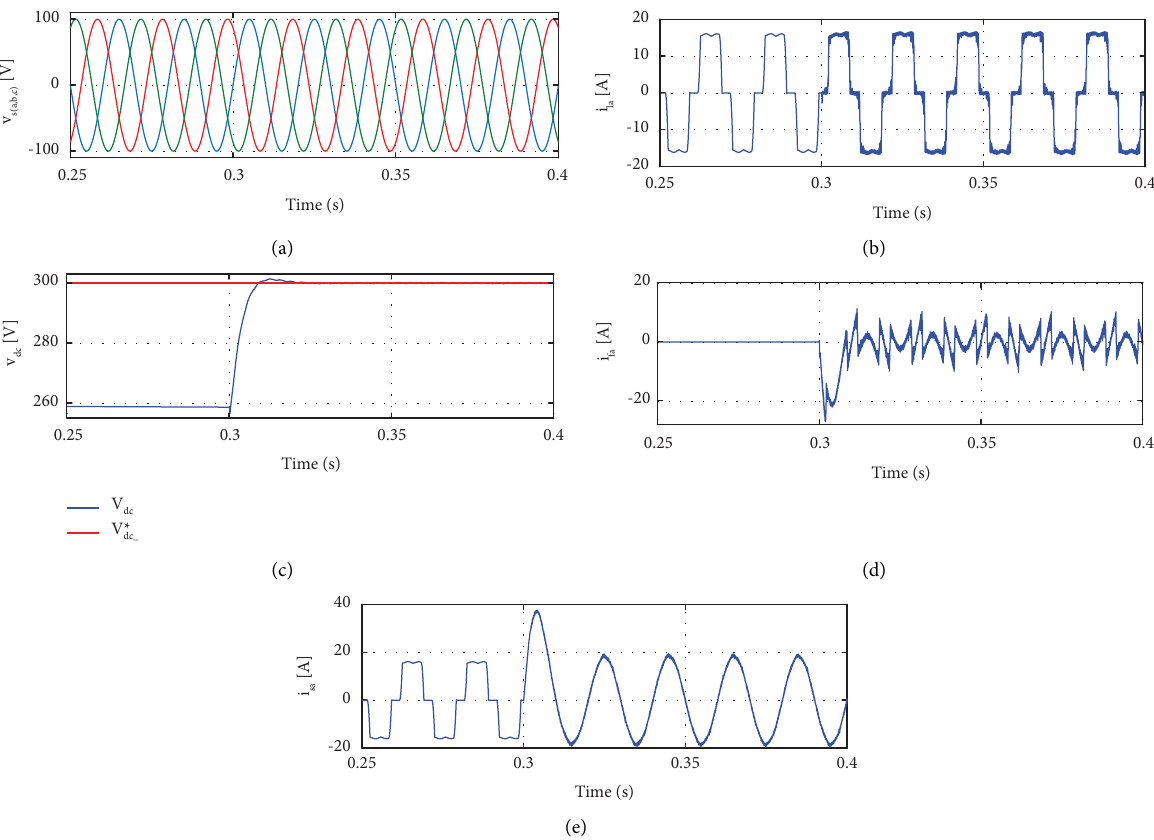
Figure 13: Experimental results: (a) source voltages ( v (e) source current ( i s1